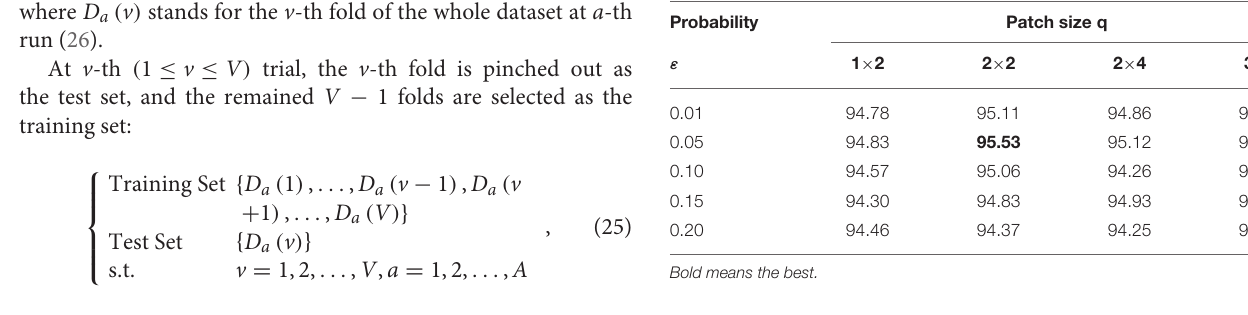
TABLE 7 | PS-related parameter optimization in terms of accuracy.